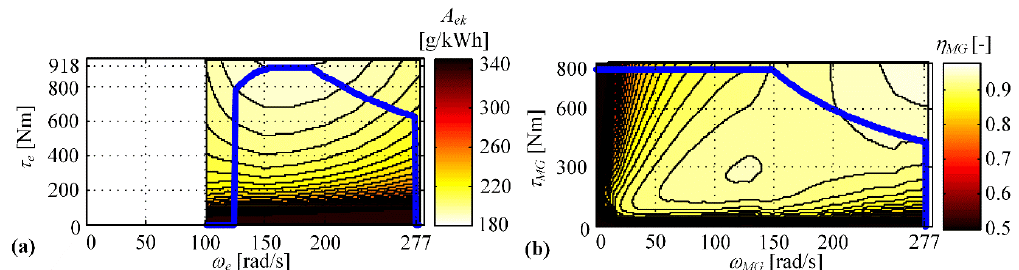
Figure 1. Parallel configuration of plug-in hybrid electric vehicles (PHEV) powertrain ( a ), transmission idle-mode power loss map ( b ), and mechanical efficiency map ( c ). Figure 2. Engine specific fuel consumption map ( a ), and electric machine (M/G) machine efficiency map ( b ), given along with maximum torque lines (denoted in blue).